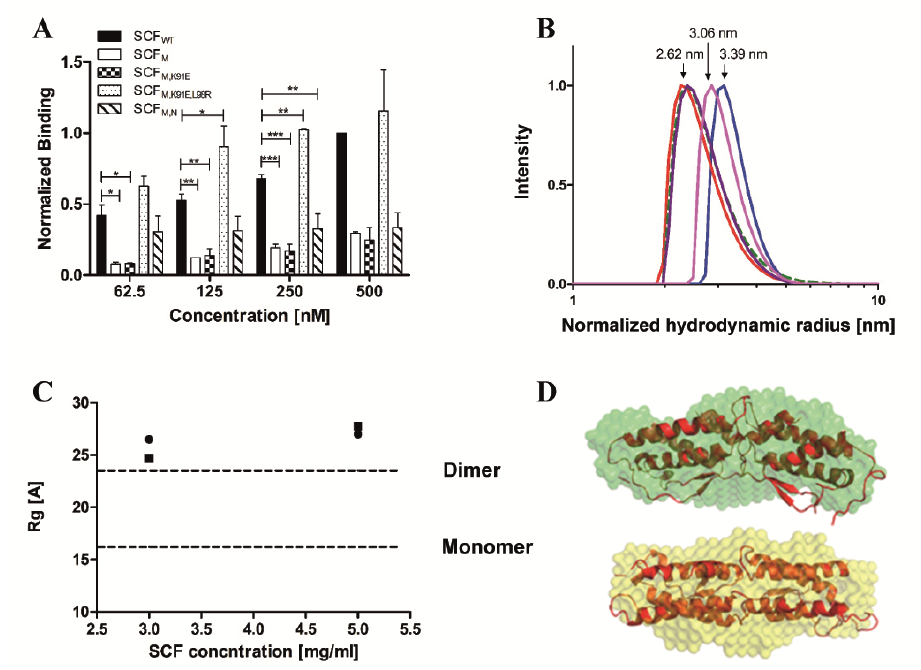
Figure 2. Mutations of SCF a ff ect dimerization. ( A ) Homo-dimerization of soluble SCF proteins with the same yeast-surface displayed (YSD) SCF protein for: SCF WT (black columns), SCF M (white columns), SCF M,K91E (checkered columns), SCF M,K91E,L98R (dotted columns) and SCF M,S64P,F126S,V131A,E134G,V139I (SCF M,N , cross-hatched columns). The values obtained for the binding of the soluble SCF proteins to YSD SCF proteins were normalized to the value that was obtained for the binding of soluble SCF WT (at 500 nM) to the YSD SCF WT . Values are given as means of three independent experiments ± SEM, * p < 0.05; ** p < 0.01; *** p < 0.001. ( B ) DLS analysis of SCF WT (blue), SCF M (red), SCF M,K91E (dashed green), SCF M,K91E,L98R (pink), and SCF M,S64P,F126S,V131A,E134G,V139I (purple). ( C ) SAXS results showing the radius of gyration (Rg) of SCF WT (circles) and SCF M (squares) that was measured at 3 and at 5 mg / mL. The Rg values for the theoretical SCF WT monomer and dimer were calculated from the crystal structure (PDB: 1SCF) and are indicated as dashed lines. ( D ) The crystal structure of the SCF dimer was aligned with the SAXS models obtained for SCF WT (green) and SCF M (orange) using PyMOL.